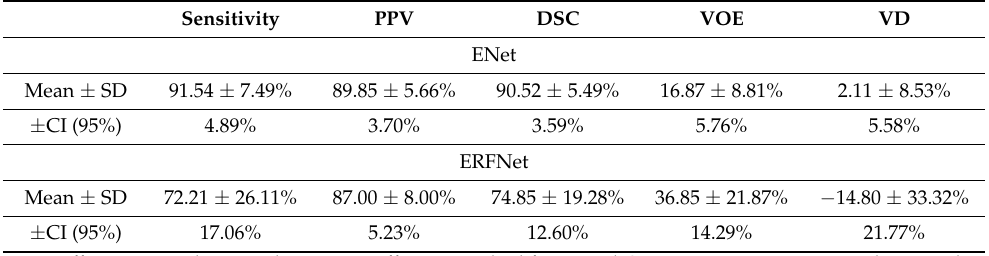
Table 3. Performance results using ENet and ERFNet (fivefold cross-validation strategy).